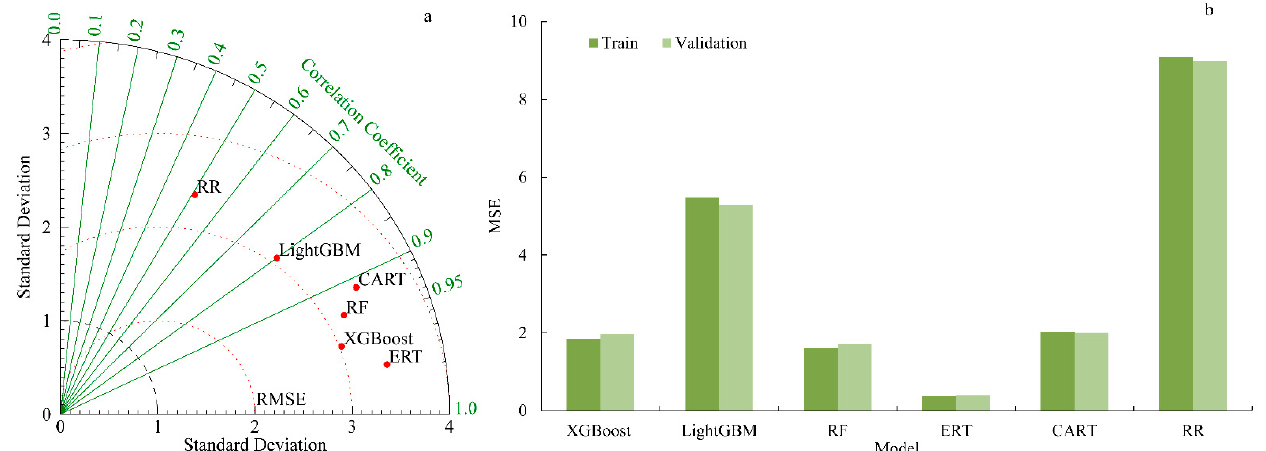
Figure 9. The normalized Taylor diagrams of the predicted and measured EC data ( a ) and the model